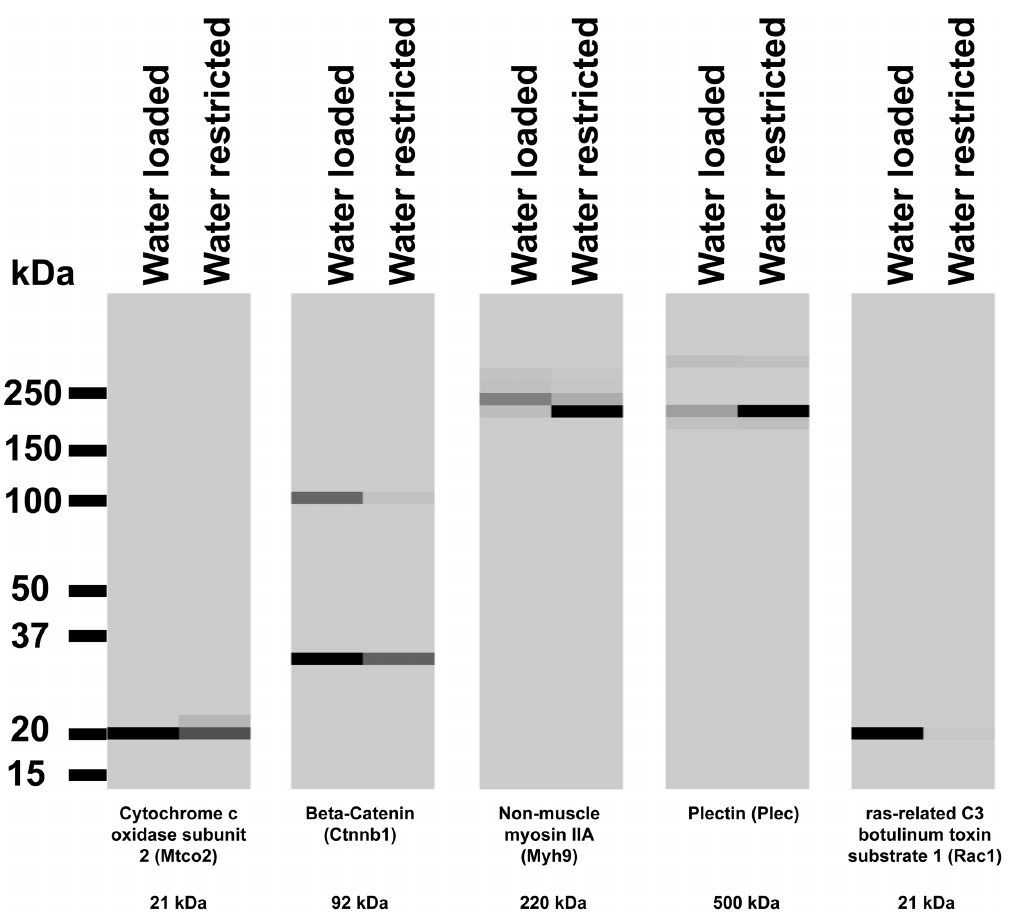
Figure 8. Heat map representation of mass spectrometry data provides a pseudo immunoblot of five carbamylated proteins. For a given protein, the pseudo immunoblot shows carbamylated peptides found in each treatment group (Water Loaded vs Water Restricted) according to molecular weight and relative abundance. Molecular weights given are theoretical, based on known amino acid sequence.